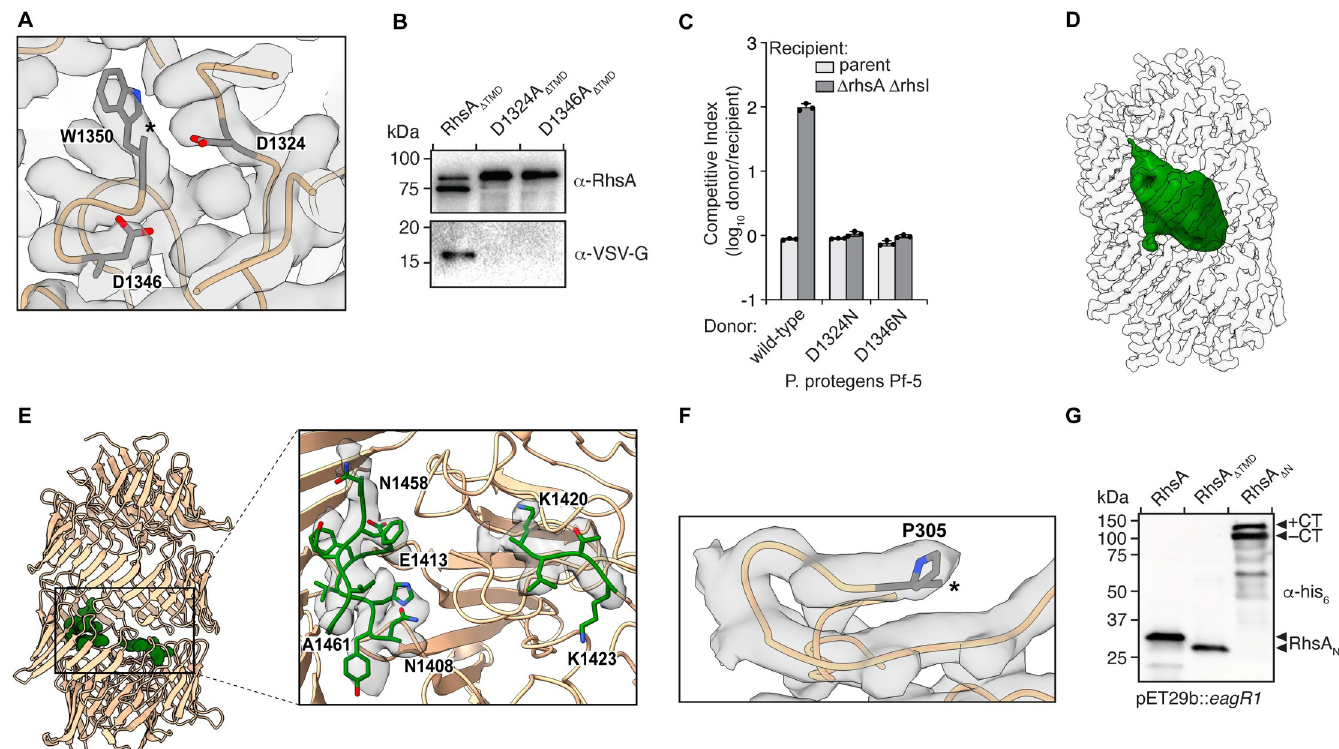
Fig 2. Autoproteolysis of RhsA occurs at its N- and C-terminus. (A) RhsA is autoproteolytically cleaved at its C-terminus at position W1350. The end of the connected density is indicated with an asterisk. Catalytic aspartates D1324 and D1346, are shown in stick representation. (B) Western blot analysis shows proteolytic cleavage of the C-terminal toxin domain. Mutation of either D1324 or D1346 to asparagine prevents autoproteolytic cleavage of the C-terminal RhsA toxin domain. Blots were performed against the Rhs barrel ( α -RhsA) and against a C-terminal VSV-G epitope tag ( α -VSV-G). (C) Outcome of intraspecific growth competition assays between the indicated P . protegens donor and recipient strains. Donor strains were competed against recipient strains that either contain (light grey) or lack the rhsA- rhsI effector-immunity pair (dark grey). The recipient strains also lack pppA to stimulate type VI secretion in donors [14]. Data are mean ± s.d. for n = 3 biological replicates and are representative of two independent experiments. (D) The toxin domain of RhsA is encapsulated by its cocoon-shaped Rhs repeat-containing domain. Difference map of the encapsulated toxin at extremely low-density threshold and low pass-filtered to 20 Å (green) is shown. The Rhs cocoon is depicted using a transparent space-filling representation at normal map threshold. (E) Regions of the toxin domain are stabilized inside the cocoon through interactions with the C- terminal autoprotease domain. The densities appear at the same density threshold as the rest of the map. The atomic models are shown in stick representation. (F) RhsA undergoes N-terminal cleavage at proline 305. The end of the density is indicated with an asterisk. (G) N-terminal cleavage occurs in RhsA and a mutant lacking the prePAAR-TMD (RhsA Δ TMD , residues 74-CT) but not in a mutant lacking the entire N-terminal region (RhsA Δ N , residues 297-CT). The indicated RhsA constructs were purified from E . coli and subject to Western blot and detected using an N-terminal His 6 -tag antibody ( α -his 6 ).